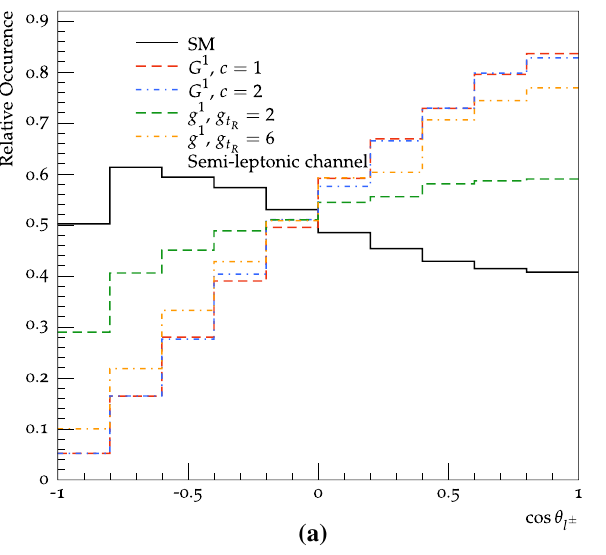
Fig. 2 cos θ l ± distributions for the SM t ¯ t and signal samples for the semi-leptonic ( a ) and di-leptonic ( b ) analyses after all analysis selec- tions and detector effects, in both for m ( t ¯ t ) > 2 TeV. Since the signal produces right-handed tops we see a large modification of these lepton